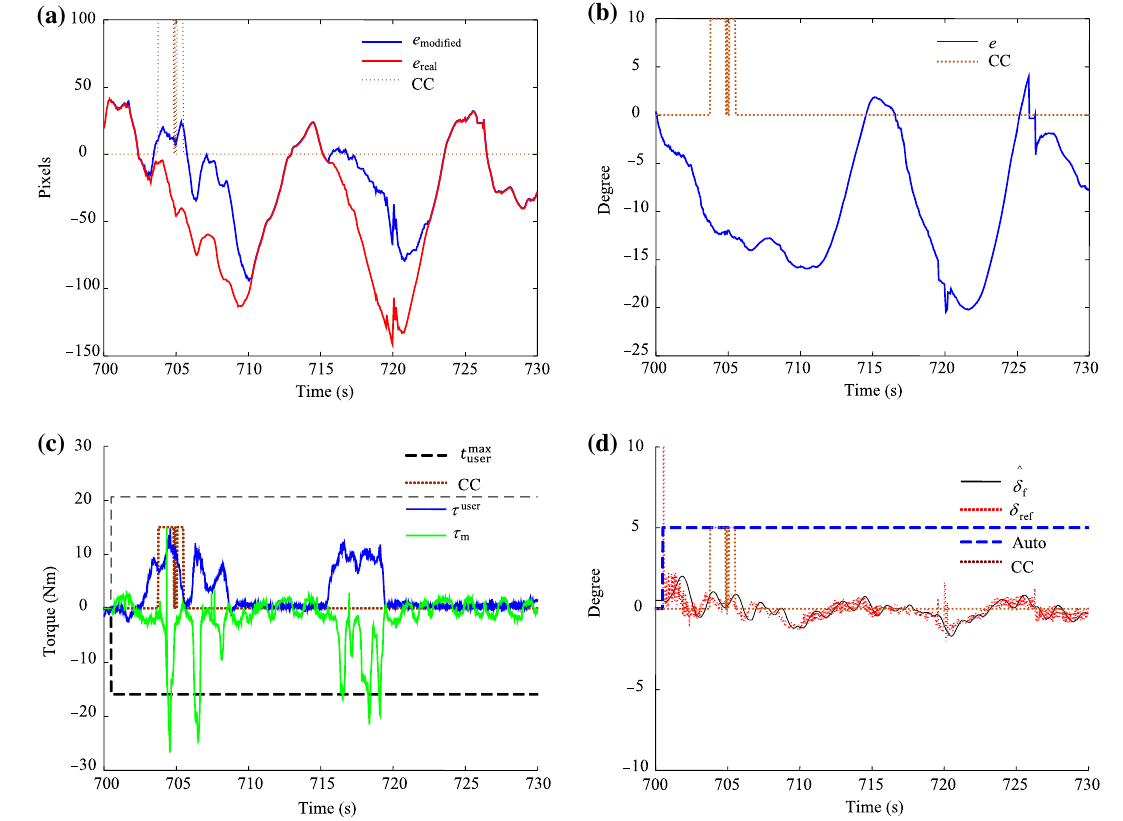
Fig. 13 Cooperative path planning. a Lateral error in cooperative path planning. b Orientation error in cooperative path planning. c Steering torque in cooperative path planning. d Estimated angle in cooperative path